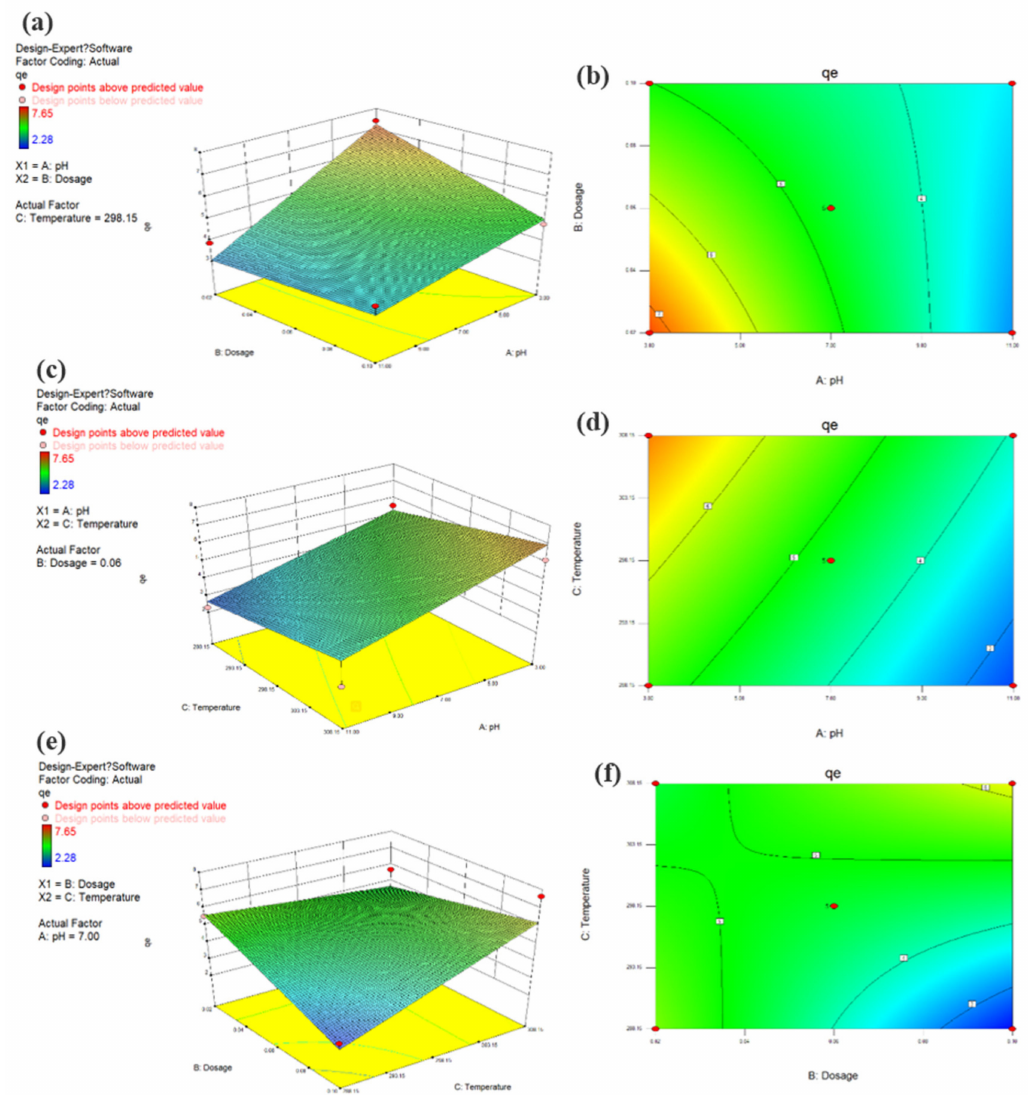
Figure 8. 3D response surface ( a , c , e ) and 2D contour lines ( b , d , f ) for adsorption capacity of CIP by